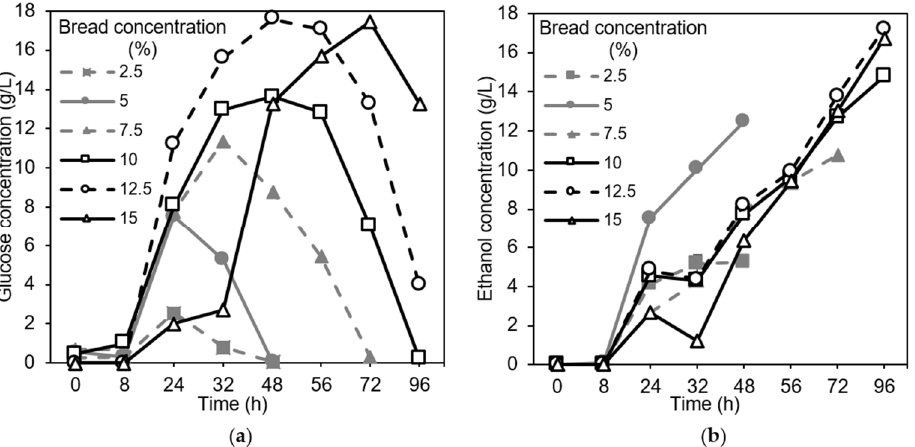
Figure 3. Profiles of ( a ) glucose and ( b ) ethanol at different concentrations of the substrate in the shake flask experiments. The standard deviations for glucose and ethanol were 0.0–1.8% and 0.0–3.8%, respectively.